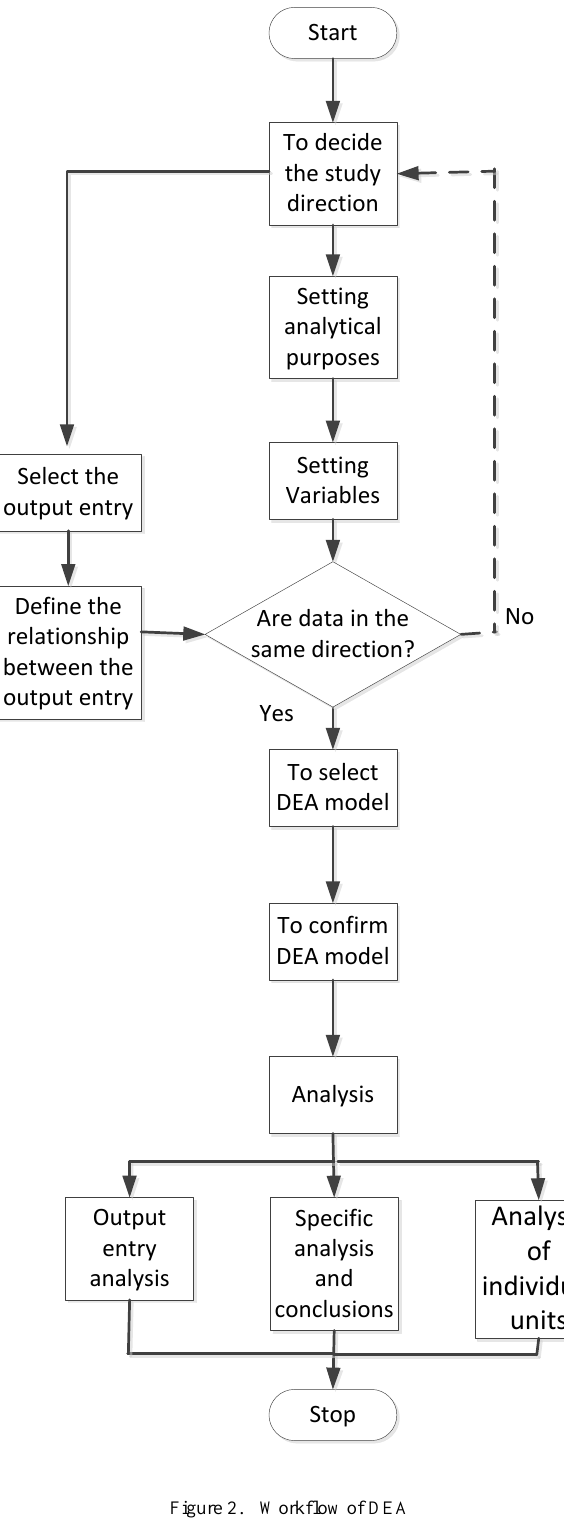
Figure 2. Workflow of DEA